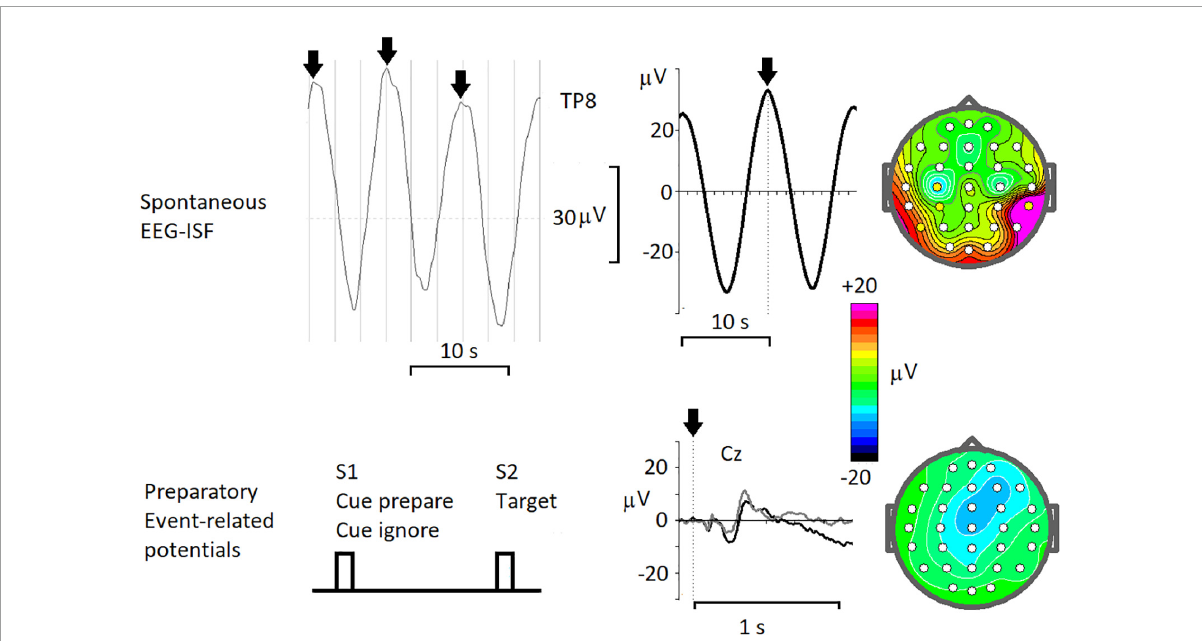
FIGURE3 Resting-state spontaneous 0.1 Hz oscillations and task-related slow shifts of the cortically recorded potentials. Spontaneous EEG-ISF- from left to right: a fragment of the spontaneous EEG ( < 0.5 Hz) at TP8 electrode in a healthy subject, arrows mark peaks of 0.1 Hz oscillations; averaged oscillations with time 0 corresponding to peaks in spontaneous EEG; map of the averaged potential at 0 time. Preparatory Event-related potentials – from left to right: the scheme of the cued task; the ERPs recorded in a healthy subject for Cue prepare, associated with preparation to the following target (black line) and for Cues ignore, associated with ignoring the trial (gray line); map of the averaged ERP for Cue prepare taken just before the